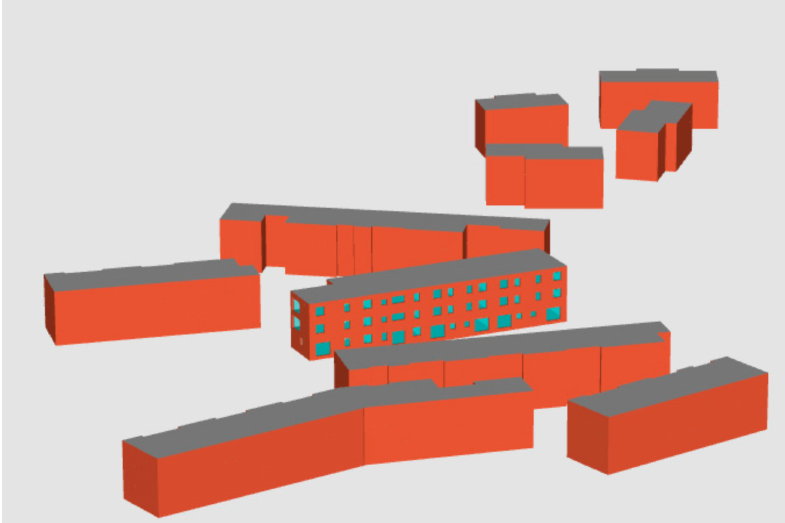
Figure 5. View of the 3D model of the neighborhood in the “density + ” (horizontal density) configuration as presented in the Pleiades software (openings only appear on the selected